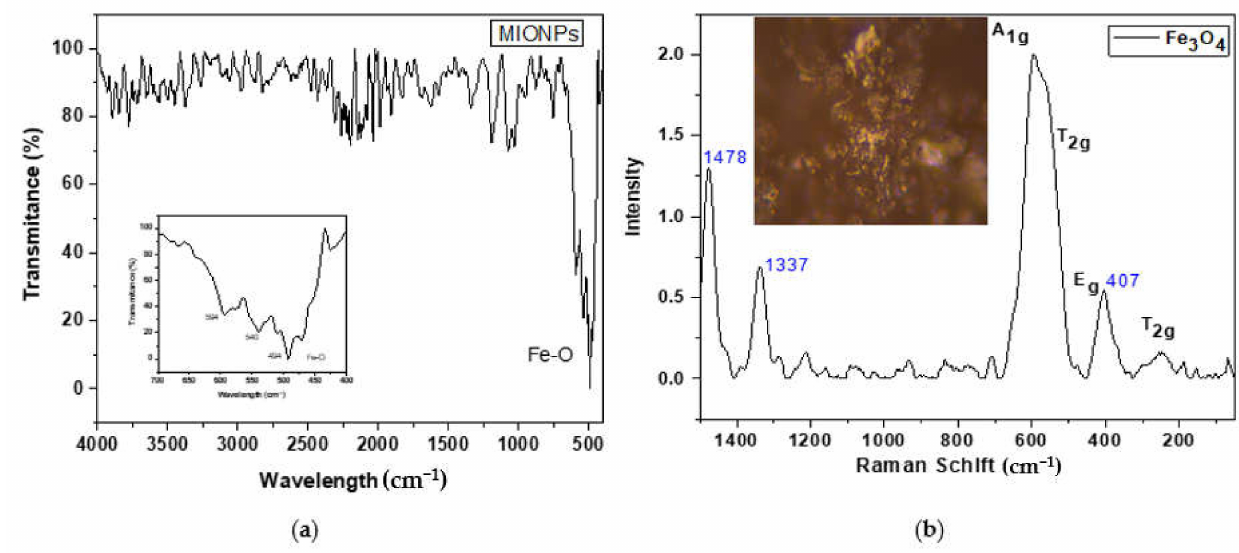
Figure 4. ( a ) FTIR and ( b ) Raman spectra with optical imagen at 50 × magnification, of